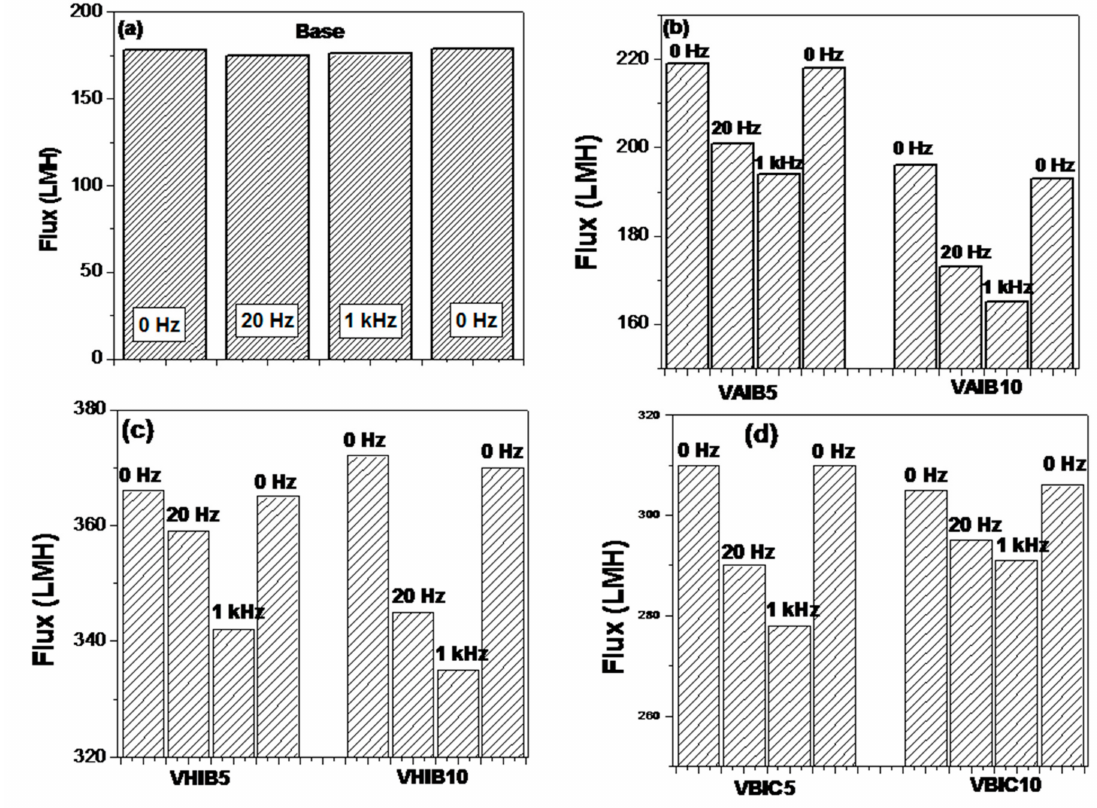
Figure 6. Water flux as a function of time for responsive membrane at di ff erent oscillating electric field frequency. ( a ): Virgin RCUF membrane; ( b ): Responsive membranes originated from vinyl allyl imidazolium bromide; ( c ): Responsive membranes originated from vinyl hexyl imidazolium bromide; ( d ): Responsive membranes originated from vinyl butyl imidazolium